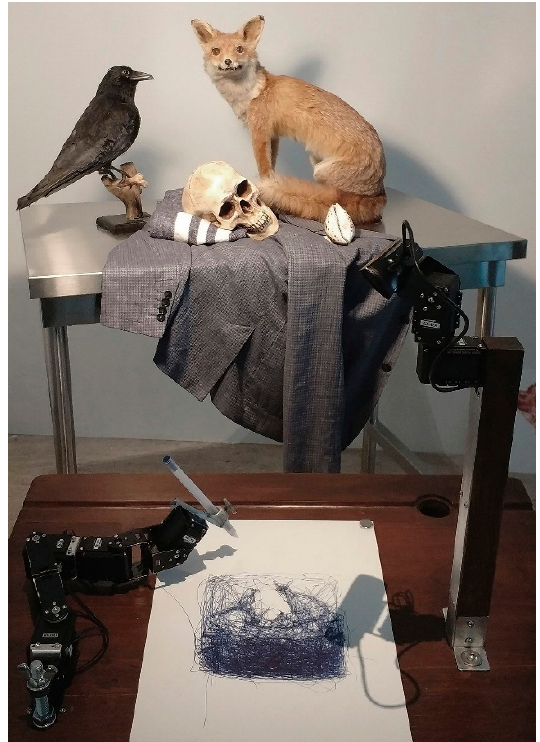
Figure 3. Human Study #2 , installation with drawing robots and still life. Image courtesy of Patrick Tresset.